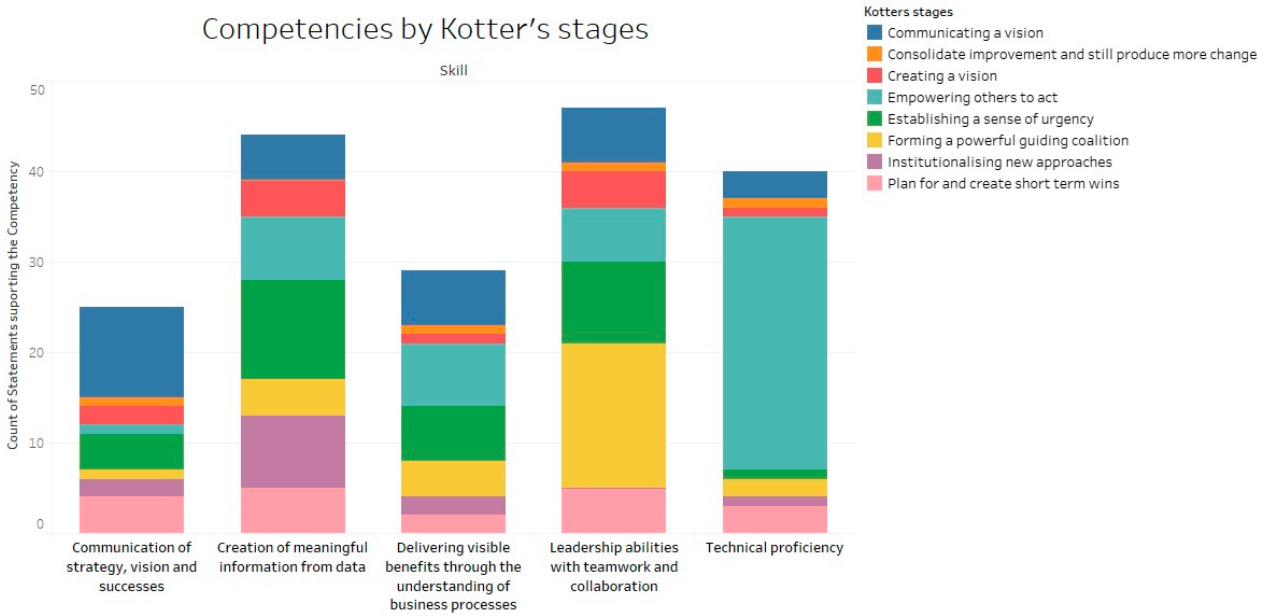
Figure 8. Top five competencies identified—developed for this study.